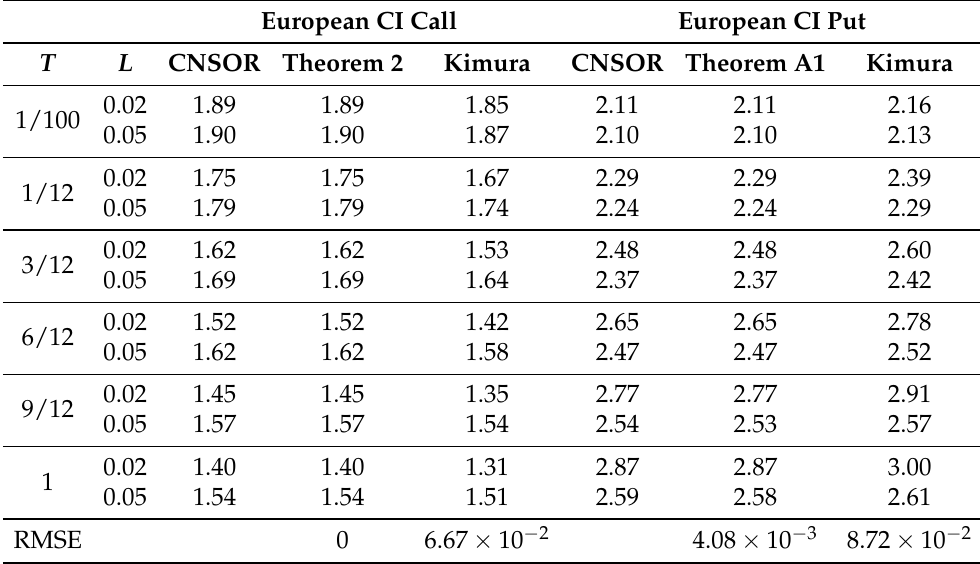
Table 2. Comparison of critical exit S z values for European CI call and put options with X = 2, r = 0.05, q = 0.04, σ = 0.2.